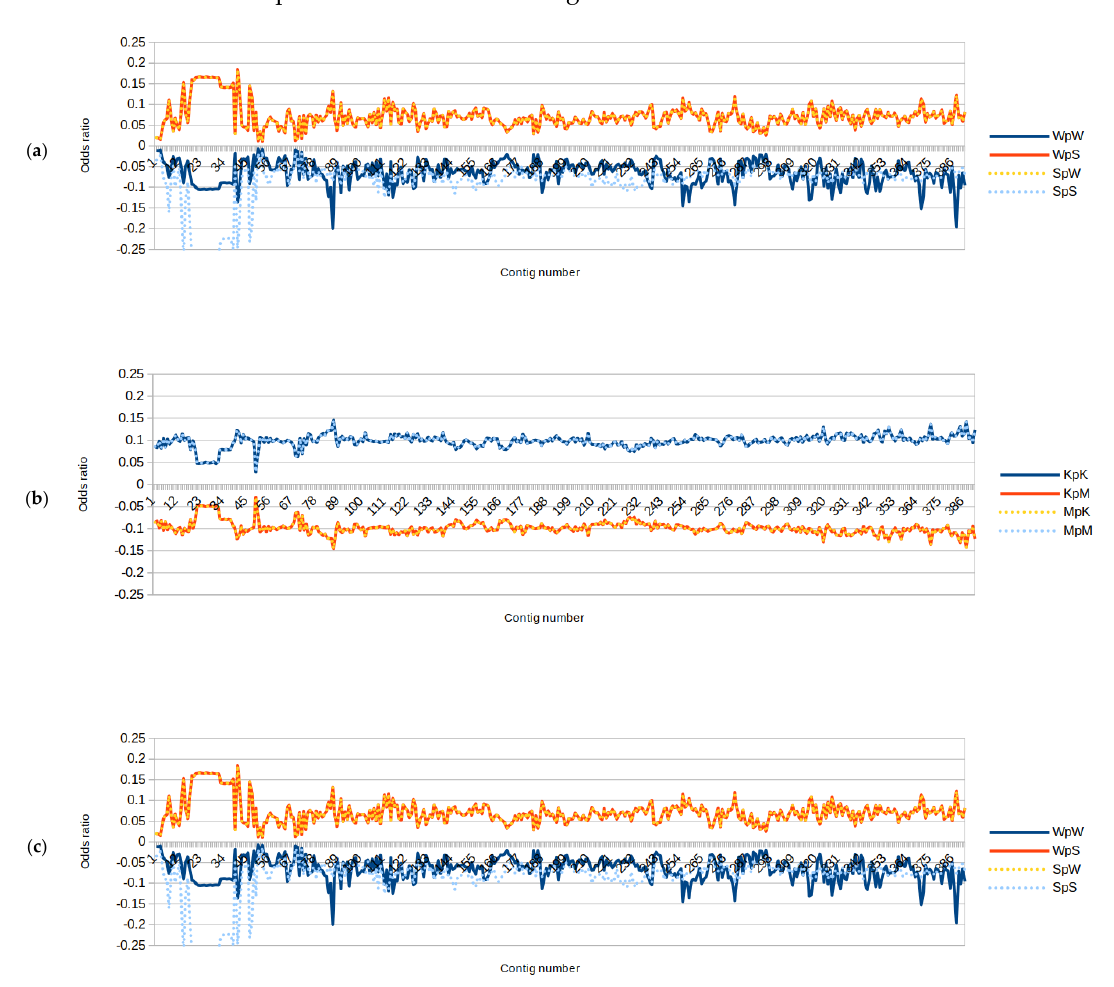
Figure 5. Dinucleotide odds ratios for each of the binary components, for 100 KB sequence segments in chromosome 22. These three graphs show traces of each of the binary components of dinucleotides across their entire length. We see that the dinucleotide’s odds ratio patterns are pervasive and stable across the chromosome. This is true for all three RY, KM, and WS components. The enhancements and suppression of the dinucleotides are seen to be constant. Those dinucleotides that are over-represented are this way throughout the chromosome. Those that are under-represented possess this characteristic across the entire chromosome. This further demonstrates the stability of the genomic signature within a human chromosome. These graphs for chromosome 22 are given as an example, however, the same stability and constant profile are true across all the human chromosomes. ( a ) RY binary component: The dinucleotides RpY/YpR are enhanced, and RpR/YpY are suppressed throughout the chromosome, and this profile is remarkably constant and stable. ( b ) KM binary component: The dinucleotides KpM/MpK are suppressed, while KpK/MpM are enhanced throughout chromosome 22. ( c ) WS binary component: Towards the telomeres and particularly at one end, there is more variation in the signature, however, it still holds. Telomeres display more repeats and sequence structures that are different, and the signatures highlight this. The WS component fluctuates the most in this regard. The WS component shows more variations, particularly towards the